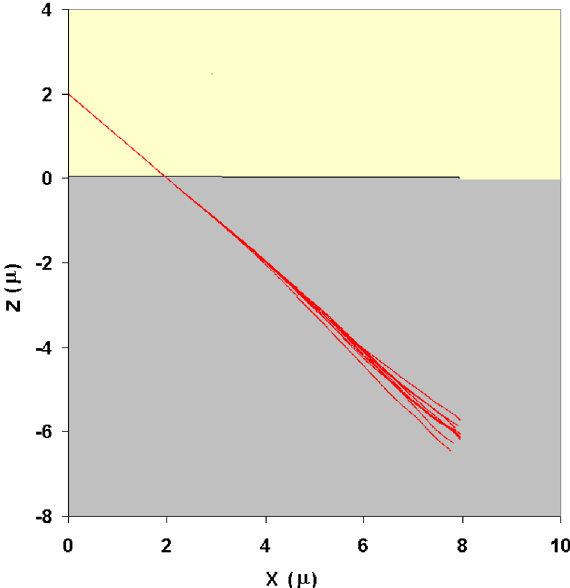
FIG. 2. (Color) Ten 182 MeV gold ion trajectories in iron generated with the Monte Carlo program for an incidence angle of 45 (cid:5)